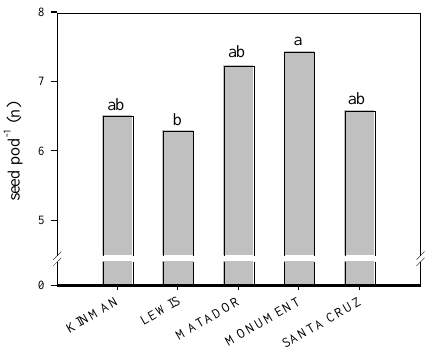
Figure 5. Two-year average seeds per pod among five guar cultivars averaged among three water regimes. Bars with different letters differ for p < 0.05.